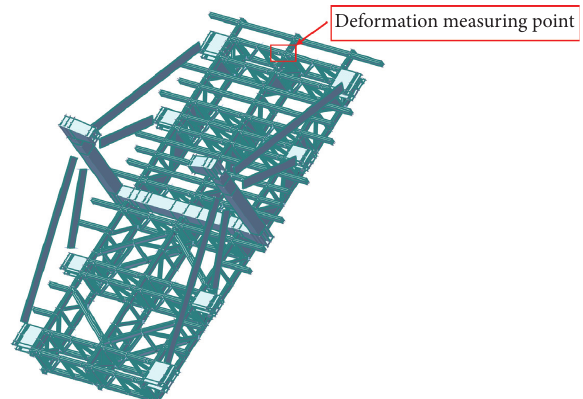
Figure 19: Layout of the deformation measuring point of the hanging